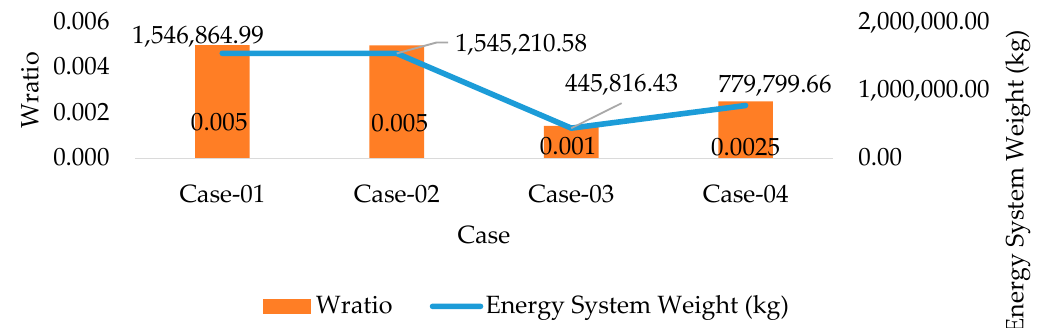
Figure 3. System Weight and W ratio of Different Energy Systems.